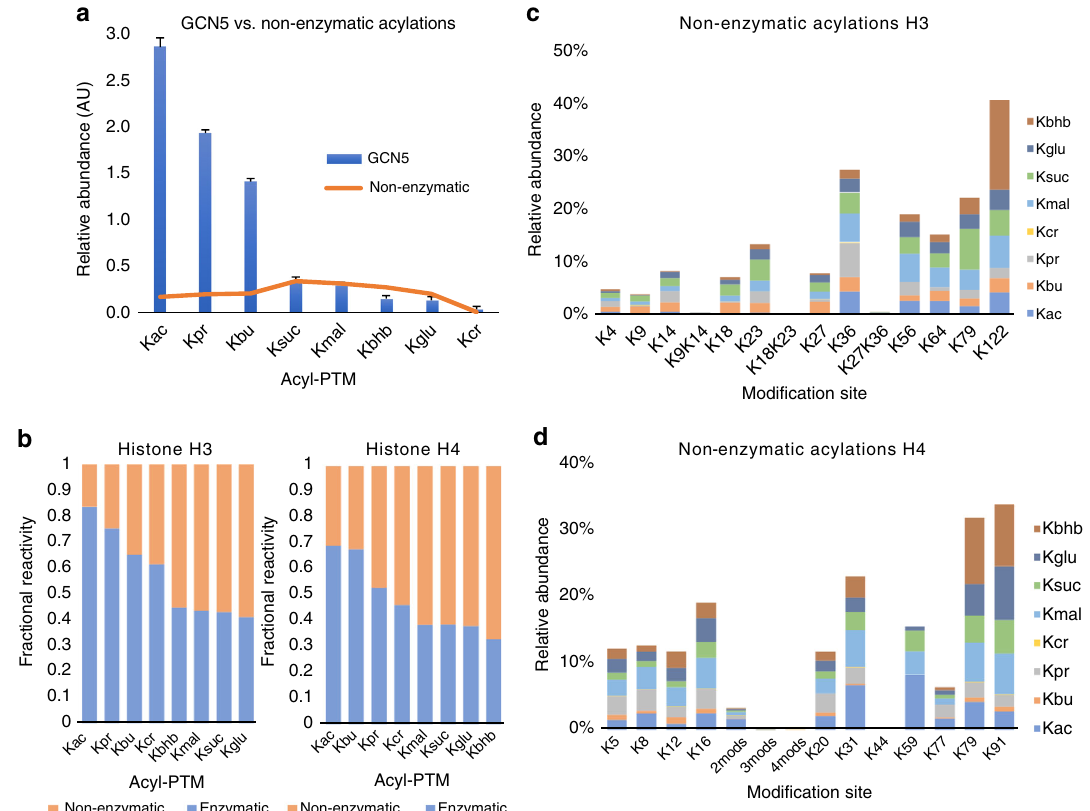
Fig. 2 Non-enzymatic versus enzymatic acylation of histones in vitro. a Comparison of non-enzymatic versus GCN5-catalyzed acylations on histone H3. The y axis (arbitrary units) represents the sum of the relative abundances of all enzymatically and non-enzymatically acylated peptides from histones H3. We can observe that the contributions for Ksuc, Kmal, Kbhb, Kglu and Kcr in the experiments with GCN5 were mostly the result of non-enzymatic acylations. b Stacked column representation of non-enzymatic reactivity divided by enzymatic reactivity of the eight acyl-CoA donors on histone H3 (left) and histone H4 (right). The fractional reactivity represents the ratio of PTM intensity in presence of all seven enzymes tested versus PTM intensity in absence of enzymes, i.e., 0.5 corresponds to identical intensities with and without enzyme. For instance, crotonylation is an overall low abundance PTM, although the majority detected on histone peptides is the result of an enzymatic catalysis. c , d Bar plot showing the relative quantitation of non- enzymatically acylated sites on c histones H3 and d histone H4. All results are shown as the average of three independent experiments and error bars represent the